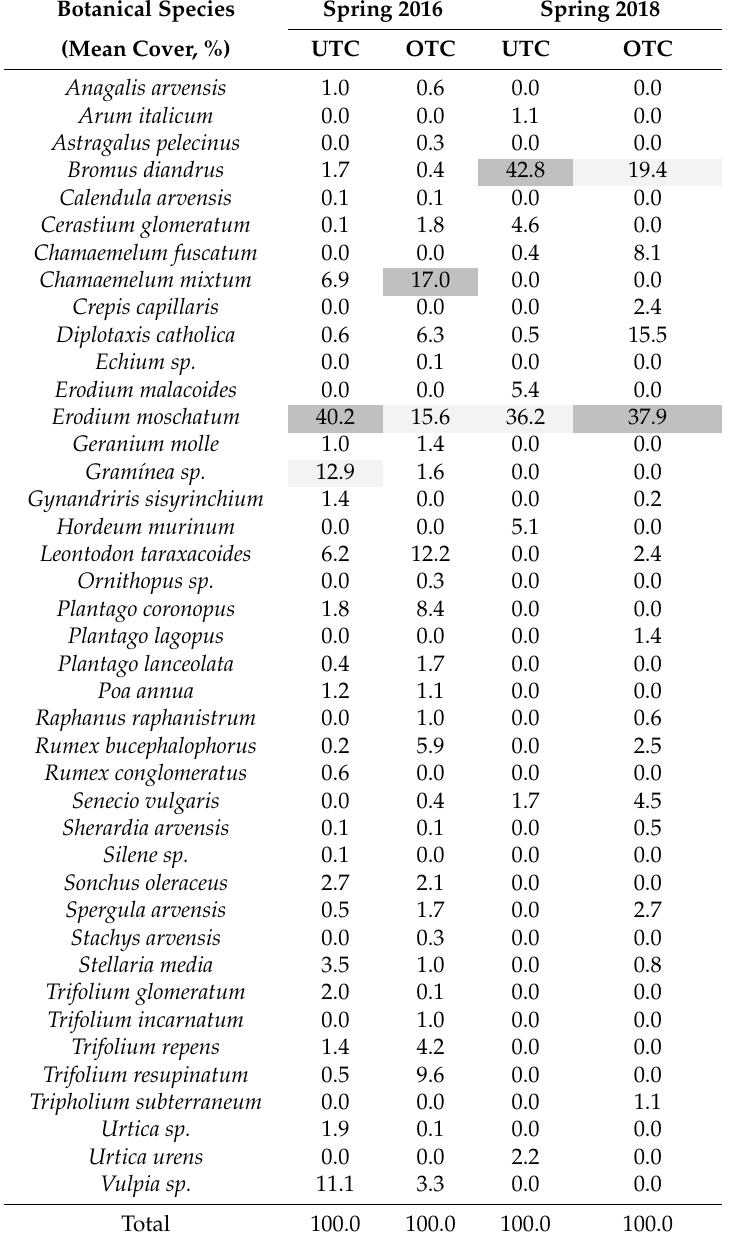
Table 5. Floristic composition (botanical species mean cover, %) of pasture of the studied field in spring 2016 and spring 2018, under tree canopy (UTC) and outside tree canopy